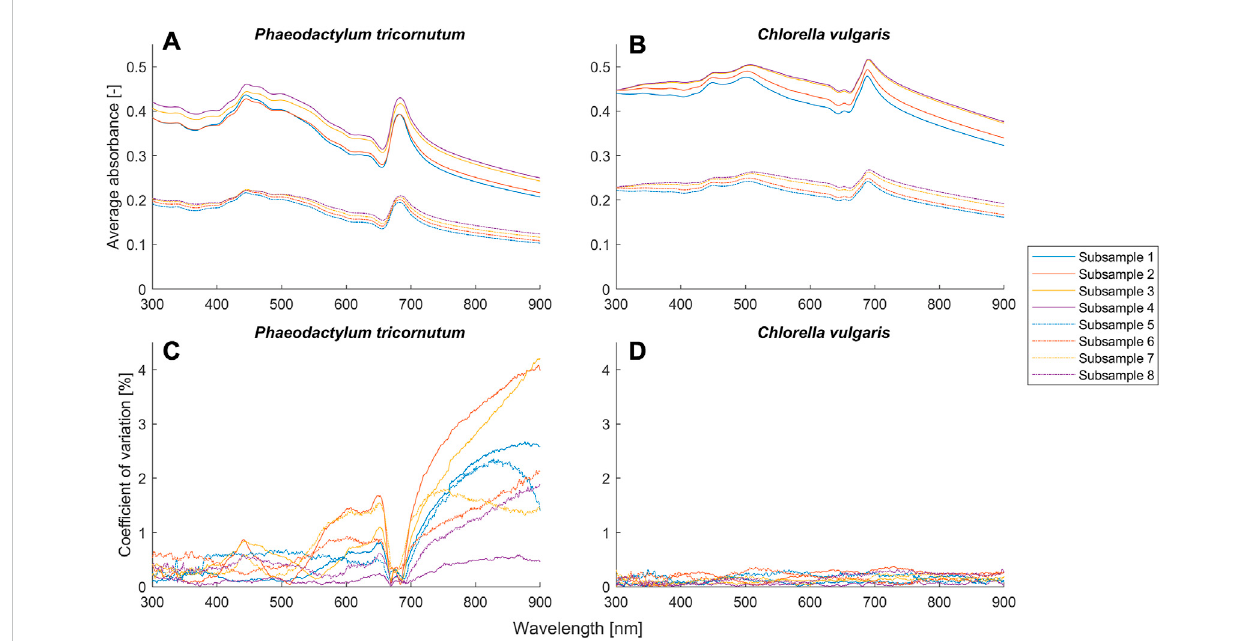
FIGURE 4 Averageabsorbanceandcoef fi cientofvariance( n =3)fordifferentsetups(Table2)ofthesuspensionsof Phaeodactylumtricornutum and Chlorella vulgaris .